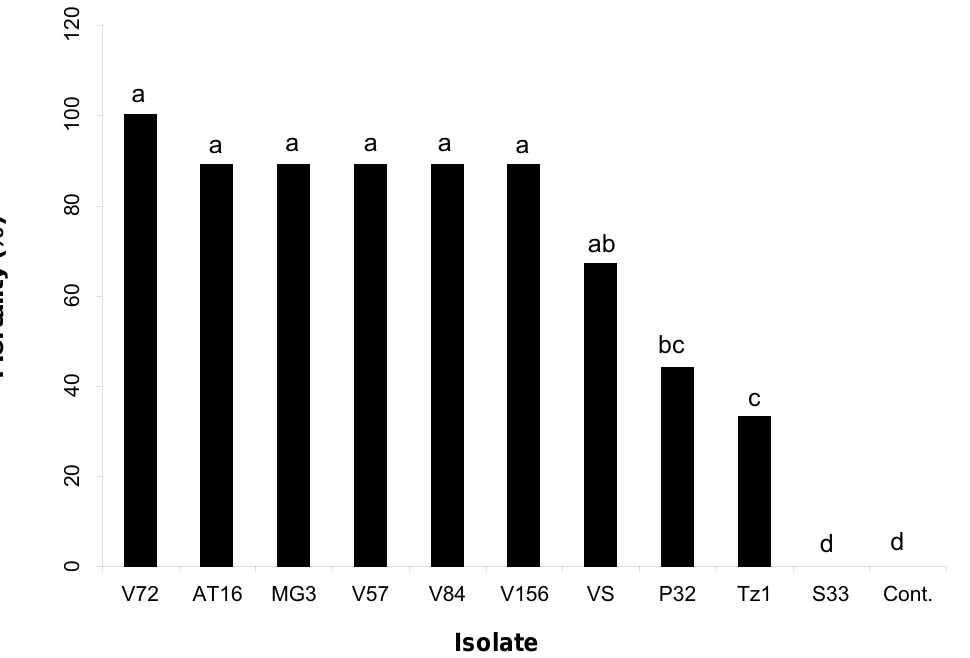
Fig. 1. Comparative pathogenicity of nine isolates of Verticillium dahliae isolated from olive in comparison to a reference strain (P32). Mean percentages of olive plant mortality showing the same letter were not significantly different ( P =0.001), Newman and Keuls test. Cont.,